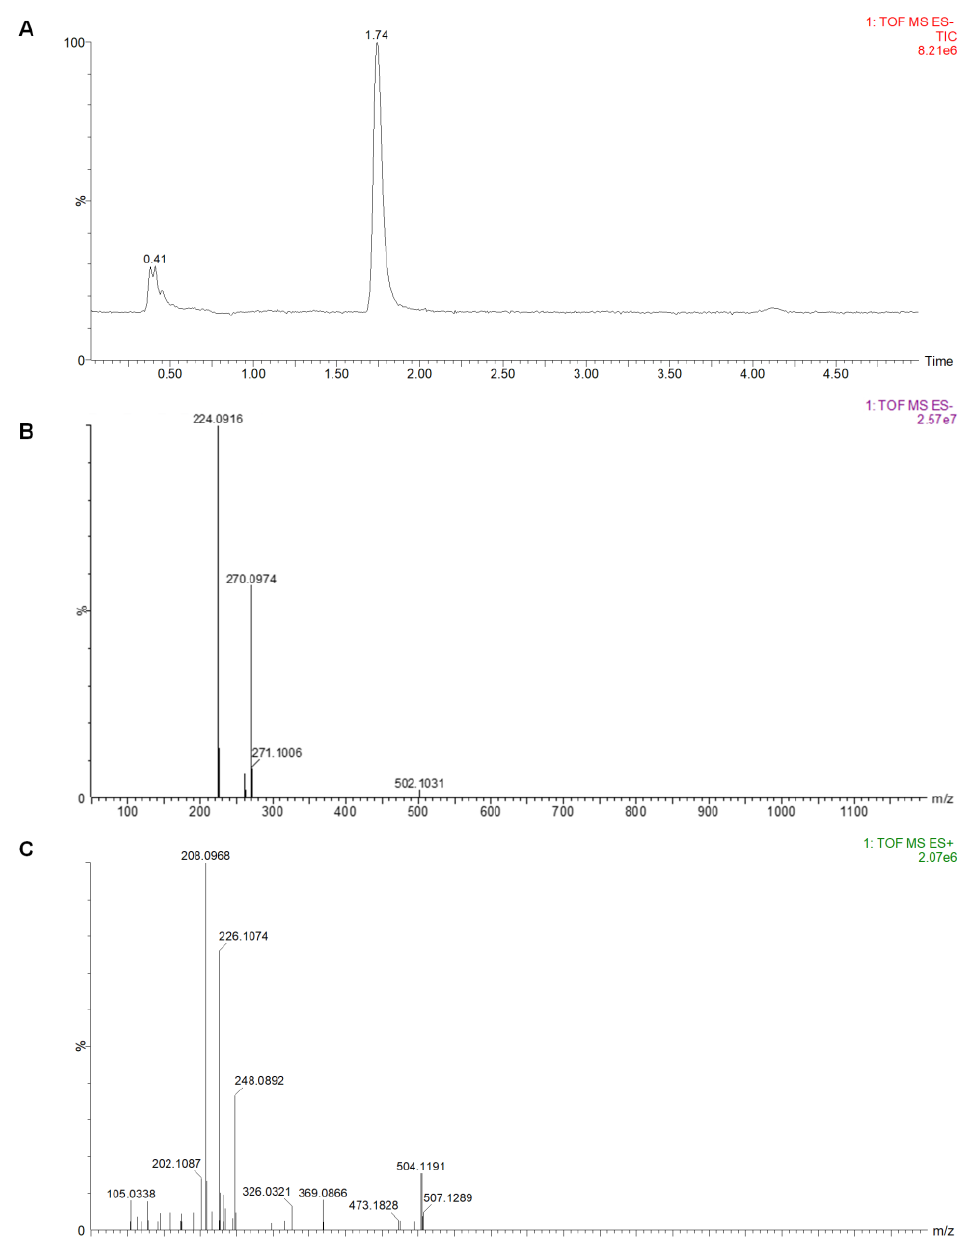
Figure 9. The mass spectra of component P2. ( A ) is the total ion flow diagram; ( B , C ) are the primary mass spectrum in negative and positive ion